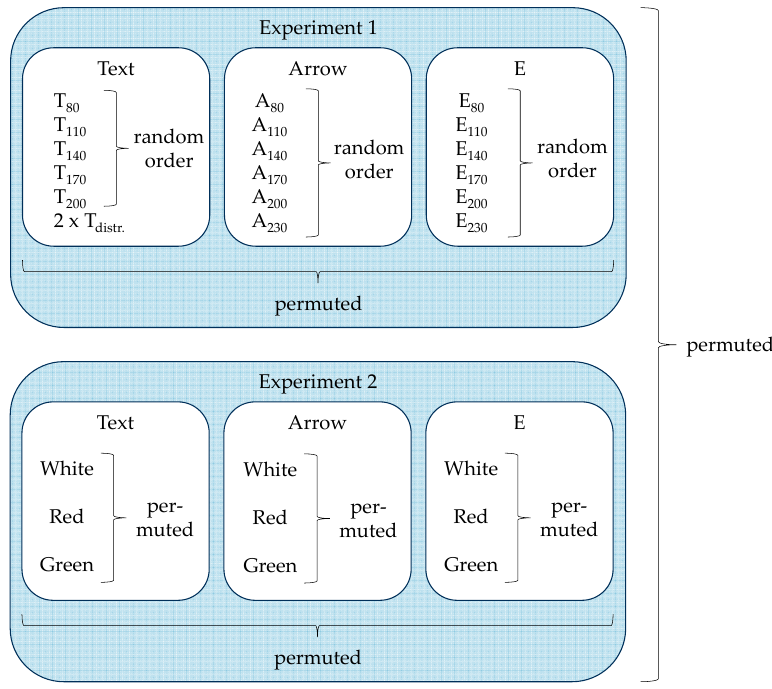
Figure 5. Experimental design dividing the study into two experiments. Both the experiments and the different content types within each experiment were presented in a permuted order.